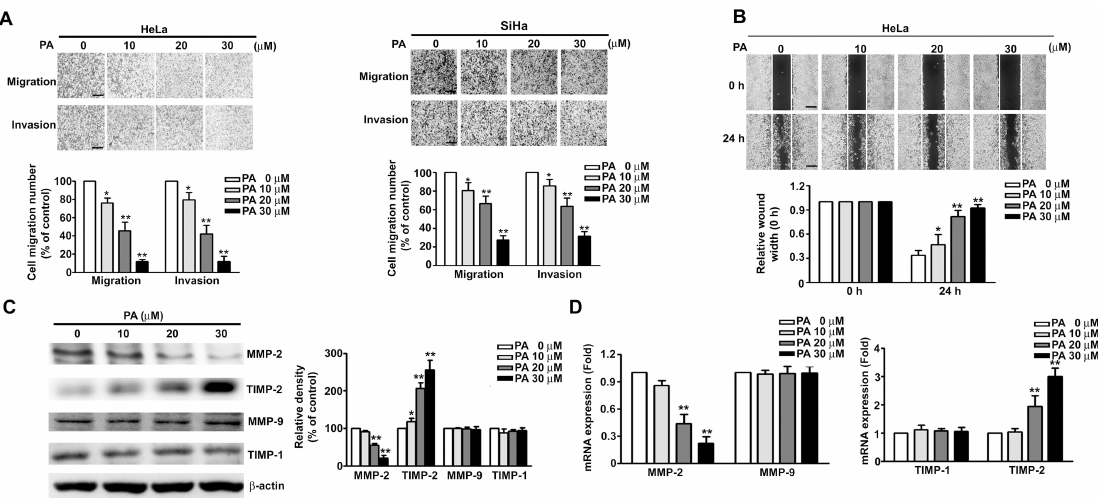
Figure 3. Effect of PA on cell migration/invasion, wound closure, and protein expression of MMPs and TIMPs in SiHa and HeLa cells. ( A , B ) Cells were treated with various concentrations of PA (0 to 30 µ M) for 24 h, followed by measurement of cell migration and invasion and relative wound width. ( C , D ) Cells were treated as above, then harvested for measurement of MMP-2, MMP-9, TIMP-1, TIMP-2 proteins and mRNAs by western blotting and RT-qPCR. Values are means and standard errors of 3 replicates. **, p < 0.01 versus control; *, p < 0.01 versus only PA treatment. Scale bar, 50 μ m.